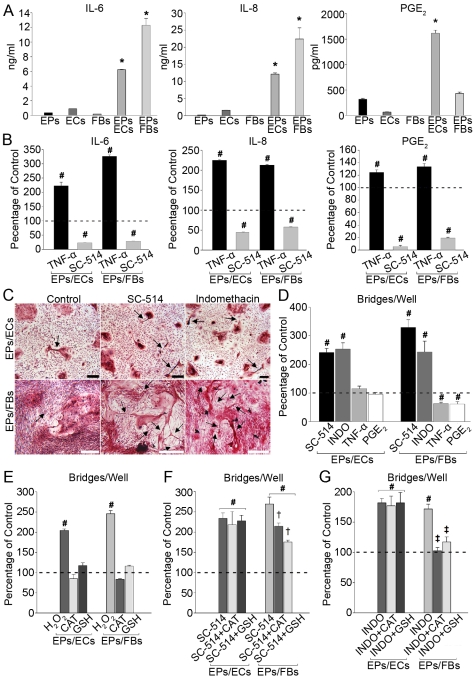
NF-κβ, COX, and ROS involvement in EP bridge formation.
A: IL-6, IL-8, and PGE2 levels in 24 h conditioned medium show increased inflammation in co-cultures vs. monocultures. *p<0.05 vs. respective monocultures, n = 4−5. B: TNF-α (25 ng/ml), an NF-κβ activator, increased IL-6, IL-8, and PGE2 secretion after 48 h. SC-514 (100 µM), an NF-κβ inhibitor, decreased secretion of all three proteins after 48 h in EPs/ECs and EPs/FBs. #p<0.05 vs. control, n = 4−5. C–D: SC-514 or indomethacin (INDO, 50 µM), a COX pathway inhibitor, caused ∼2–3 fold increases in EP bridges, arrows denote EP bridges, for both EPs/ECs and EPs/FBs after 48 h, n = 6−8. Scale bars, 250 µm. TNF-α or PGE2 (10 µM) decreased EP bridges in only EPs/FBs. #p<0.05 vs. control, n = 3−4. E: H2O2 (250 µM) increased EP bridges in co-cultures, while antioxidants, CAT and GSH, had no effect on control EP bridges after 48 h. Addition of CAT or GSH diminished stimulation of EP bridge formation caused by SC-514 or INDO only in EPs/FBs after 48 h. #p<0.05 vs. control; †p<0.05 vs. SC-514; ‡p<0.05 vs. INDO; n = 3−4. Error bars indicate SEM.